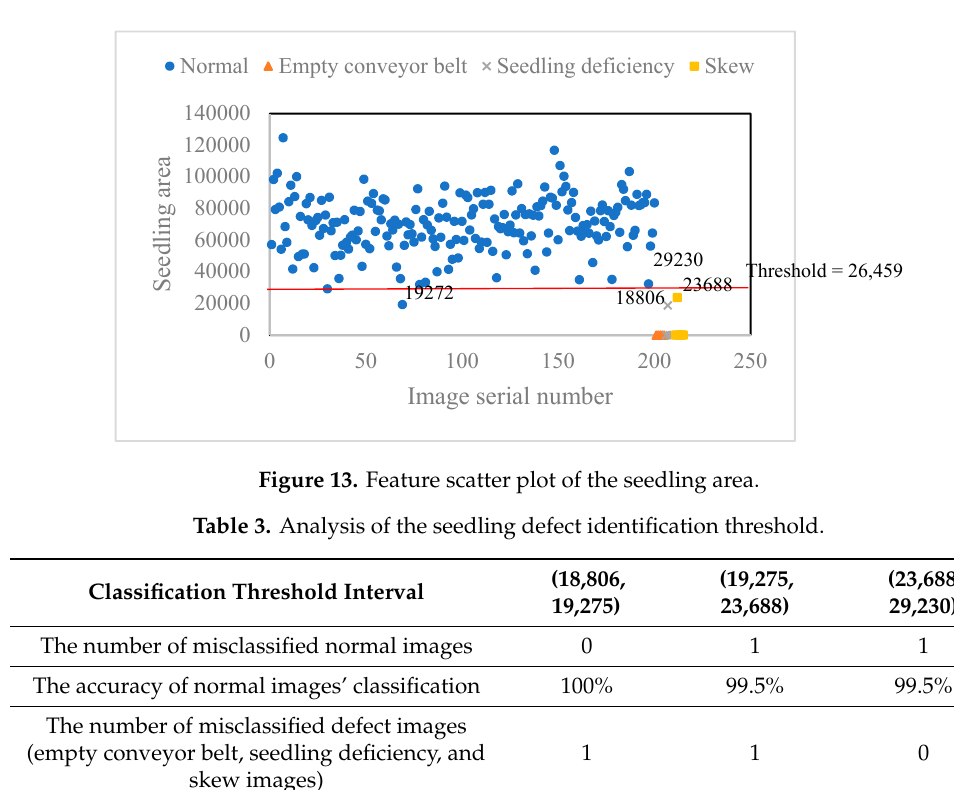
Table 2. The substrate and seedling feature of cabbage seedling defects.